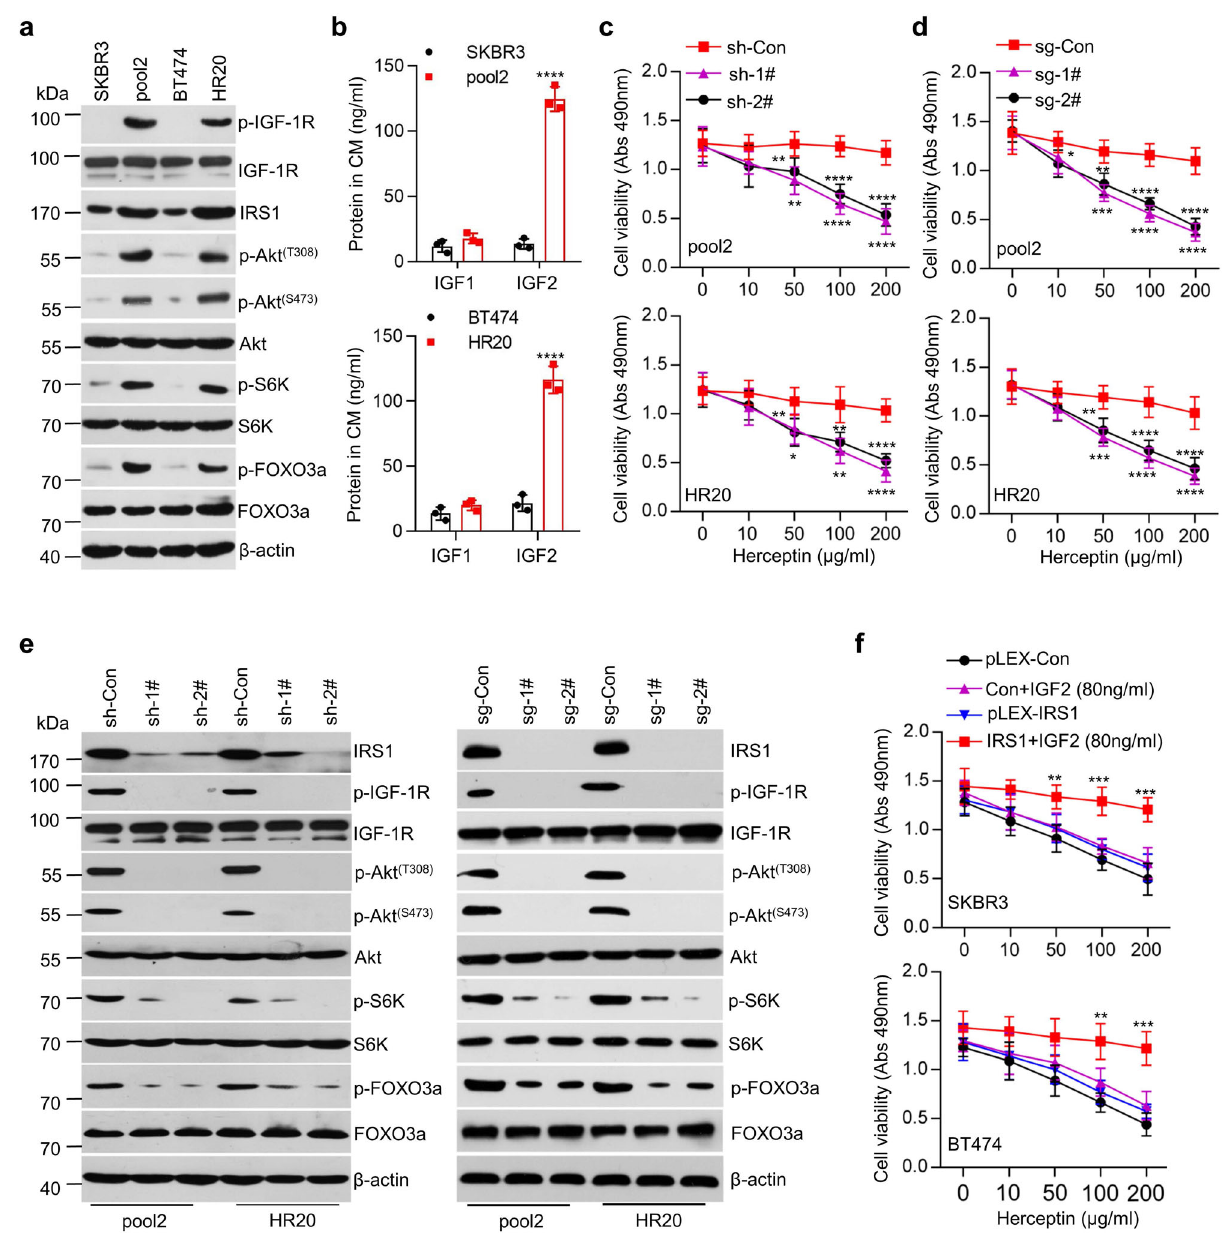
Fig. 1 IGF2/IGF-1R/IRS1/Akt/mTOR signaling pathway was involved in resistance to Herceptin in HER2-positive breast cancer cells. a SKBR3, pool2, BT474, and HR20 cells cultured at normal condition were collected and subjected to western blot analyses of p-IGF-1R, IGF-1R, IRS1, p-Akt (T308) , p-Akt (S473) , Akt, p-S6K, S6K, p-FOXO3a, FOXO3a, and β -actin. b The levels of IGF1 and IGF2 in conditioned medium (CM) were measured by ELISA, **** p